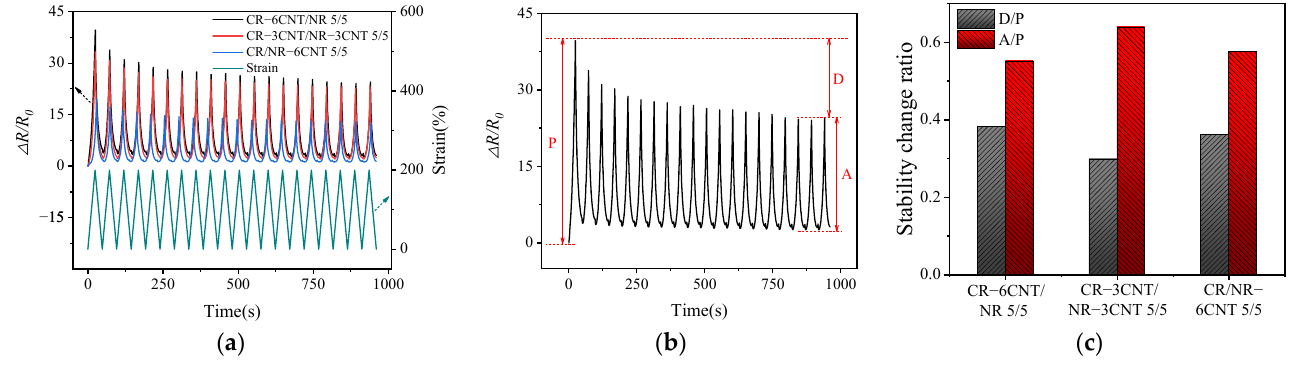
Figure 7. ( a ) The variation of ∆ R/R 0 under cyclic strain in MWCNT/CR − NR composites, ( b ) schematic diagram of P, D, A, ( c ) stability of resistance variation under different co − blending processes.